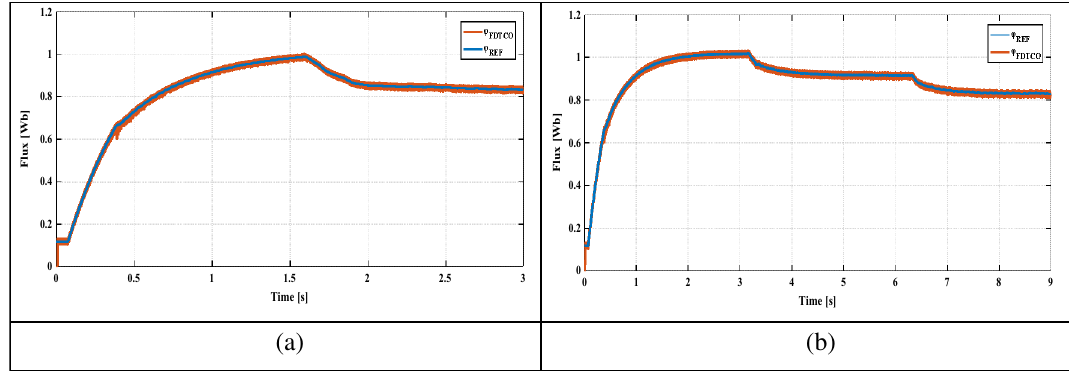
Figure 11. PIL test results for flux